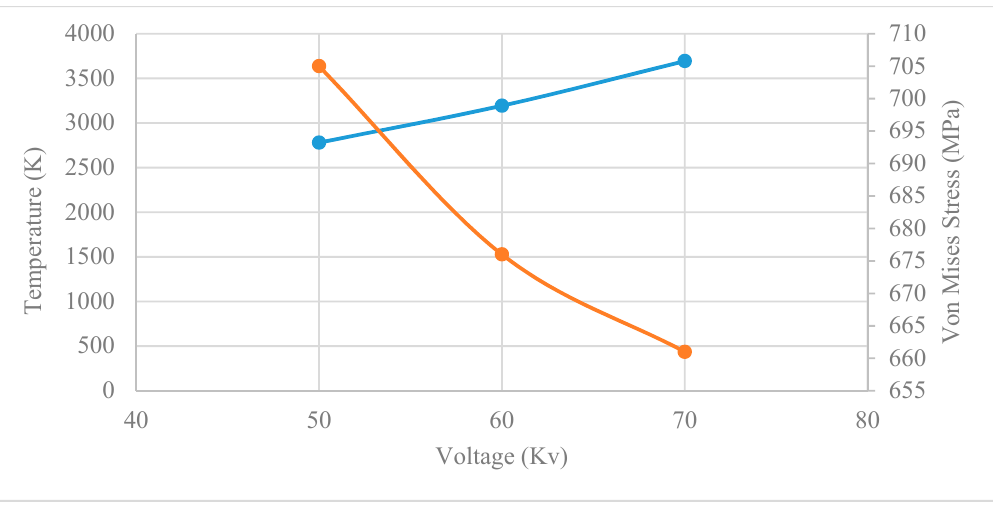
Figure 26. Voltage vs temperature & Von Mises Stress.